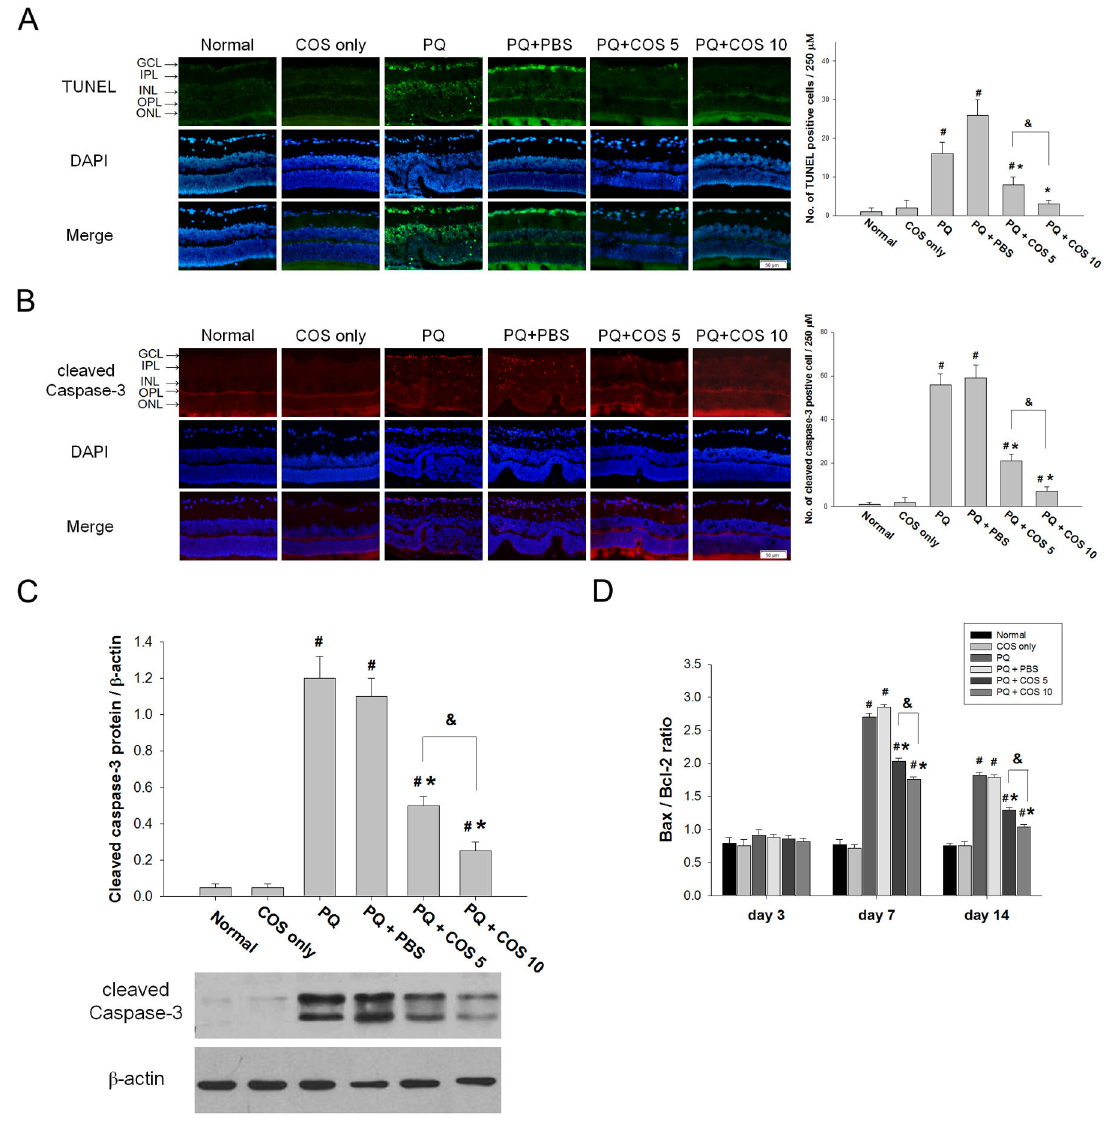
Figure 3. Effects of COS on retinal cell apoptosis. (A). Retinal apoptosis was evaluated by using TUNEL stain. In PQ only and PBS-treated group, TUNEL-positive cells were detected in GCL of the retina, whereas only sparse TUNEL-positive cells in GCL of retina were noted in COS-treated group at day 14. (B). Retinal sections and staining with anti-cleaved caspase-3 antibody. There are significantly few cleaved caspase-3-positive cells in GCL of retina in COS-treated group than in the PQ only and PBS-treated group at day 14. (C).Effects of COS on the expression of cleaved caspase-3 protein in retina. The protein level of cleaved caspase-3 in retina was evaluated by western blot analysis. The cleaved caspase-3 protein was significantly lower in the low-dose and high-dose COS treatment group than in the PQ only or PBS-treated group at day 14. (D). Effects of COS on Bax/Bcl-2 ratio. The amounts of Bax and Bcl-2 in retina were measured by ELISA and the ratio was calculated. Treatment with low-dose or high- dose of COS caused significantly decrease in Bax/Bcl-2 ratio at day 7 and 14. (* P < 0.05 compared with PQ only or PBS-treated group; # P < 0.05 compared with normal; & P < 0.05 by ANOVA test with post hoc Bonferroni test; N=3 for each group in each time point). doi: 10.1371/journal.pone.0077323.g003 N=3 in each group) and 14 ( P <0.01, low-dose vs. PQ only or treated group; two-way ANOVA with post hoc Bonferroni test ; PBS-treated group; P <0.01, high-dose vs. PQ only or PBS- N=3 in each group) (Figure 3D).